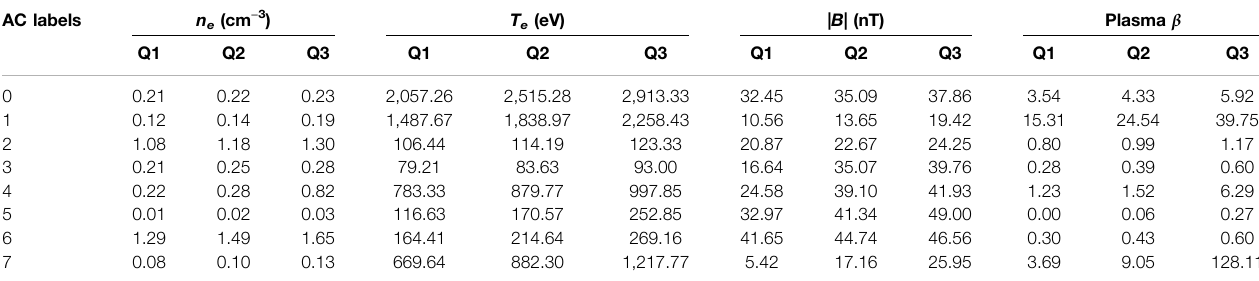
TABLE1| Comparisonsofthemedian,Q2,andupper,Q3,andlower,Q1,quartilevaluesoftheelectrondensity n e ,electrontemperature T e ,magnetic fi eld| B |,andplasma β associated with each of the eight clusters. AC